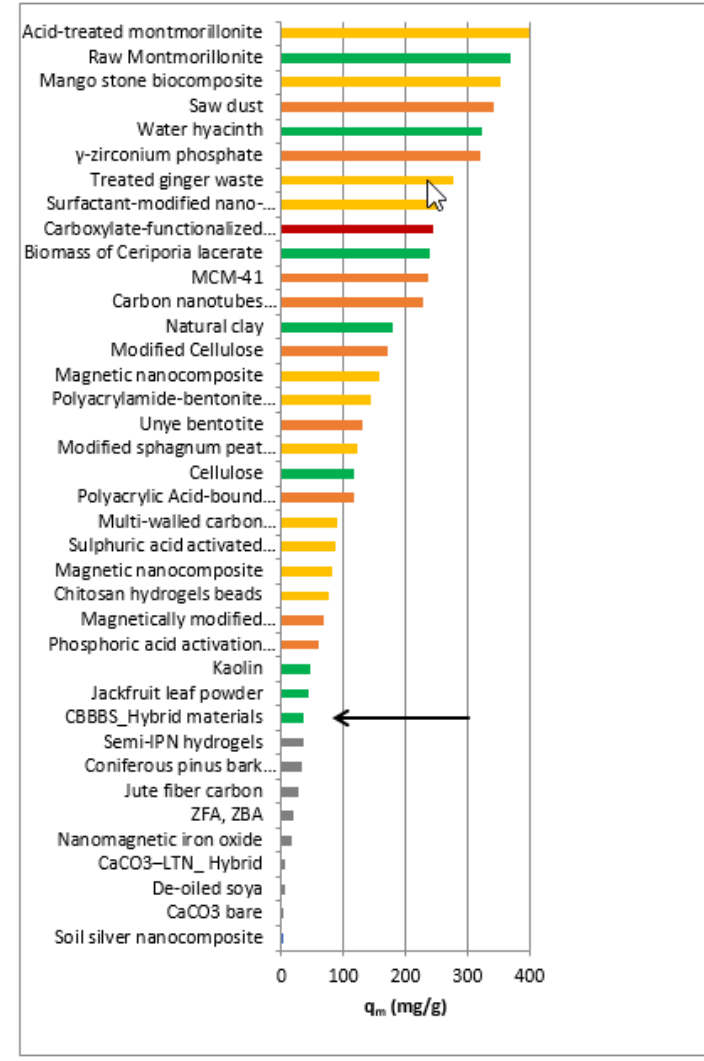
Figure 8. Removal of CV from aqueous solution by A -BBS and adsorbents materials reported in the literature and listed in this work (Table 1). The colors have been assigned on the base of aspects related to possible upscaling of the processes involving the materials: energy consumption, multistep / complex synthesis, use of non-green compounds, as described in the text.